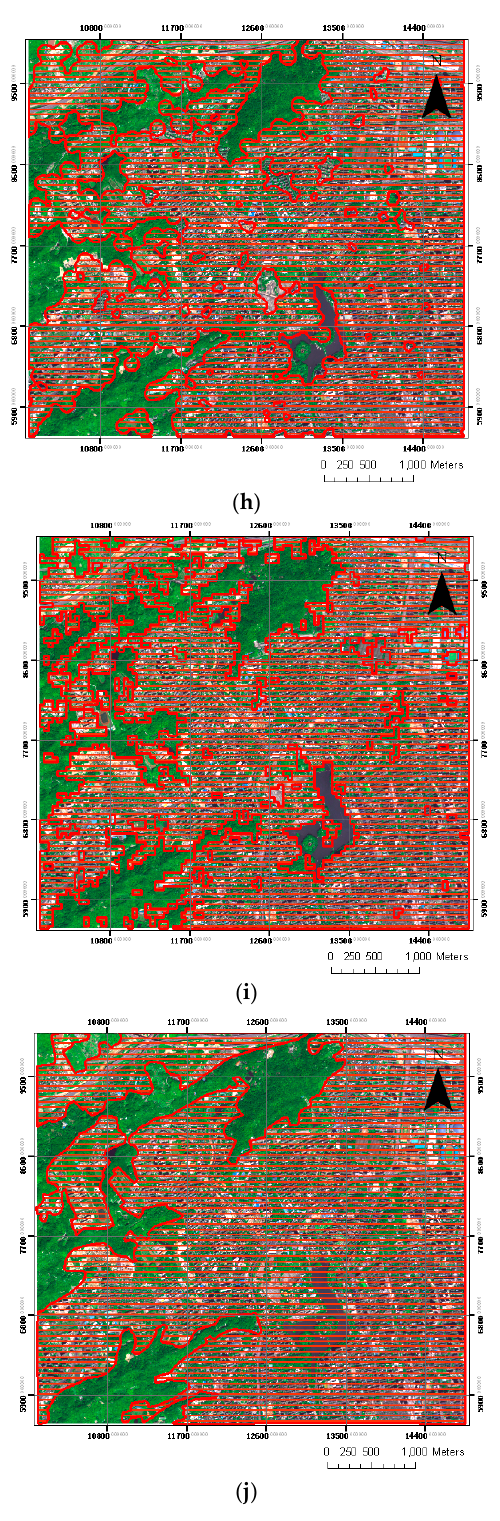
Figure 3. The first test image; the intermediate results of our method and the extracted built-up areas. ( a ) The VHSR satellite image; ( b ) the detected line segments; ( c ) Harris corners; ( d ) the detected right angle corners and right angle sides; ( e ) the detected road marks; ( f ) the retained corners and line segments; ( g ) the constructed thematic image by spatial voting; ( h ) the final built-up area (by our proposed method) imposed on the original image; ( i ) the final built-up area by the PanTex method; ( j ) the reference built-up